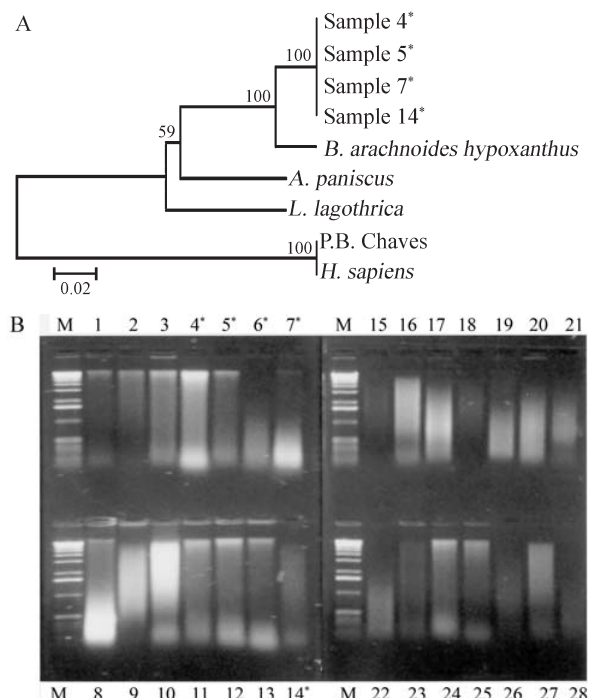
Figure 1 - A. Neighbor-joining tree showing DNA sequences of Brachyteles hypoxanyhus (accession numbers DQ118288, DQ118289, DQ118290 and DQ118291 corresponding to Samples 4*, 5*, 7* and 14*, respectively, this paper) clustered together, and closely related to Brachyteles arachnoides hypoxanthus (AF216253), Ateles paniscus (AF216247) and Lagothrix lagothrica (AF216251). Human control (ac- cession number DQ118287, this paper) is grouped with Homo sapiens (AP008260). Bootstrap values (1000 replicates) are shown above bran- ches B. DNA profiles (6 (cid:2) L/lane), numbers correspond to 28 DNA ex- tracts. “M” identifies the 1 kb ladder. Asterisks refer to samples 4, 5, 6, 7 and 14 used in PCR amplification.